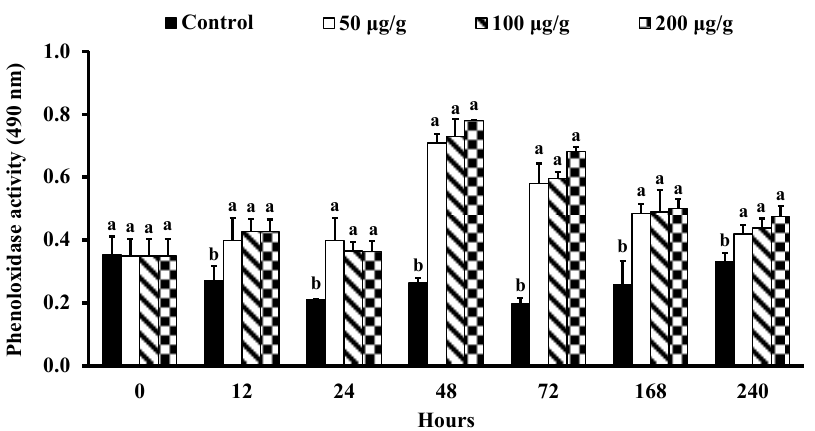
Figure 4. PO activity of Litopenaeus vannamei that received the water extract of Panax notoginseng at 50, 100, and 200 µ g (g shrimp) − 1 and control shrimp. Data are expressed as mean ± SD ( n = 8). Different superscript letters indicate that the same exposure time significantly differs ( p < 0.05) among groups (Duncan’s multiple range tests).